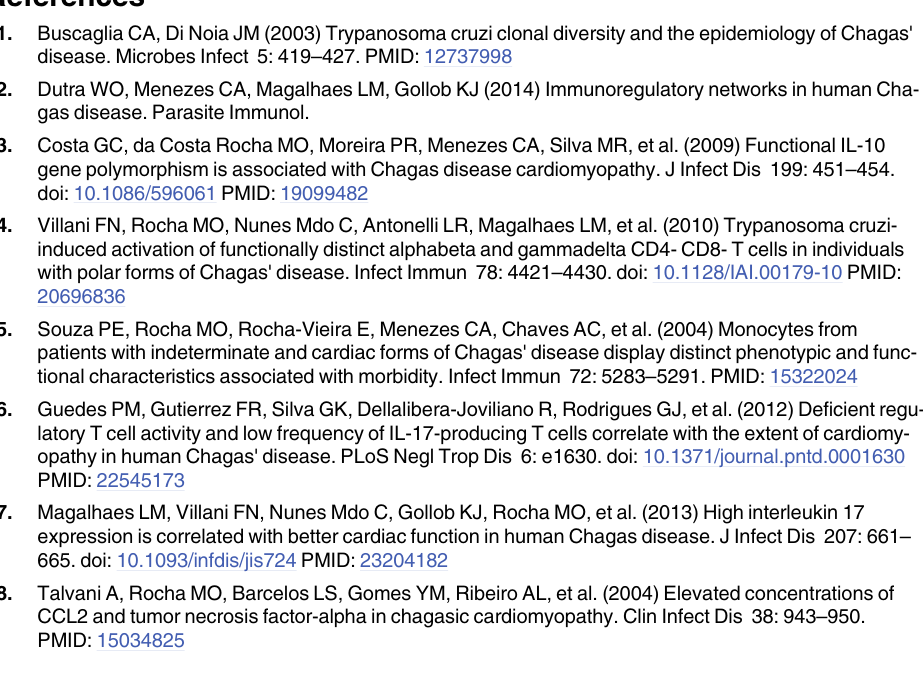
S1 Fig. Determination of the MFI of CD80 and CD86 in human monocytes infected or not with strains of T . cruzi . Results are expressed as average ± standard deviation. Determination of mean intensity of (A) CD80 in CFSE+ monocytes after 15 hours of culture; (B) CD80 in CFSE- monocytes after 15 hours of culture; (C) CD86 in CFSE+ monocytes after 15 hours of culture; (D) CD86 in CFSE- monocytes after 15 hours of culture. (TIFF) S2 Fig. Analysis of the infectivity of CD4+, CD8+ and CD14+ cells by Y strain and Col cl.1.7. Representative dot-plots of the analysis of infection of CD4 and CD8+ cells (gated on lymphocytes) and CD14+ cells (gated on monocytes) by the different isolates. The first three panels show media control and the others show Y strain and Col cl1.7, for each cell population. The figure shows that CD4+ and CD8+ cells display very low infection by both strains and that monocytes are the main infected cell population. Moreover, no differences were observed when comparing monocyte infectivity by Y and Col cl1.7 isolates (quantitative data shown in Fig 1C and 1D).